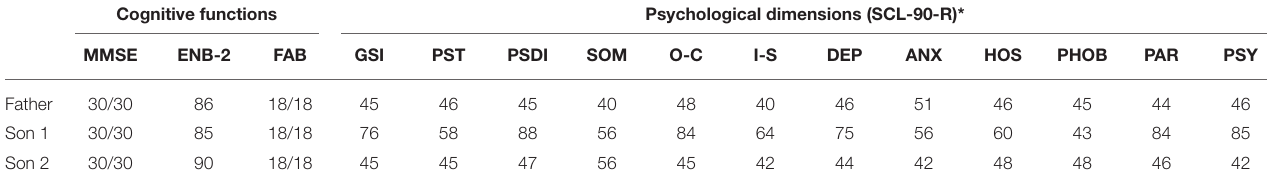
TABLE 3 | A neuropsychological and psychological assessment of a family. Cognitive functions